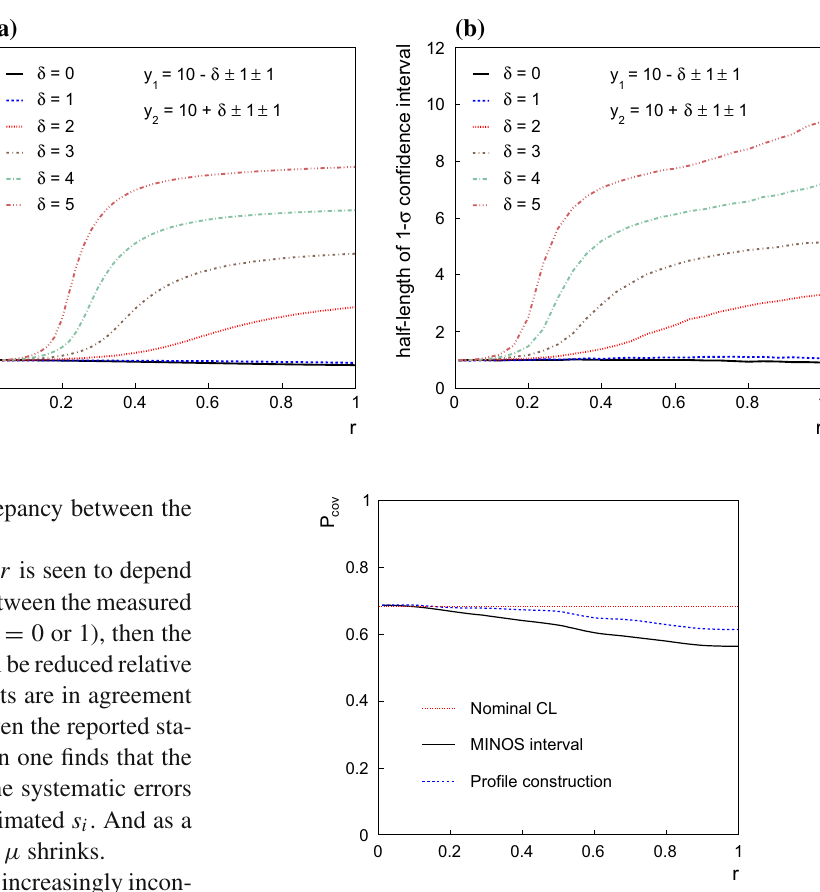
Fig. 8 Thecoverageprobabilityoftheintervalsbasedonthelikelihood (MINOS method) and on profile construction (hybrid resampling) as a function of the parameter r (see text)